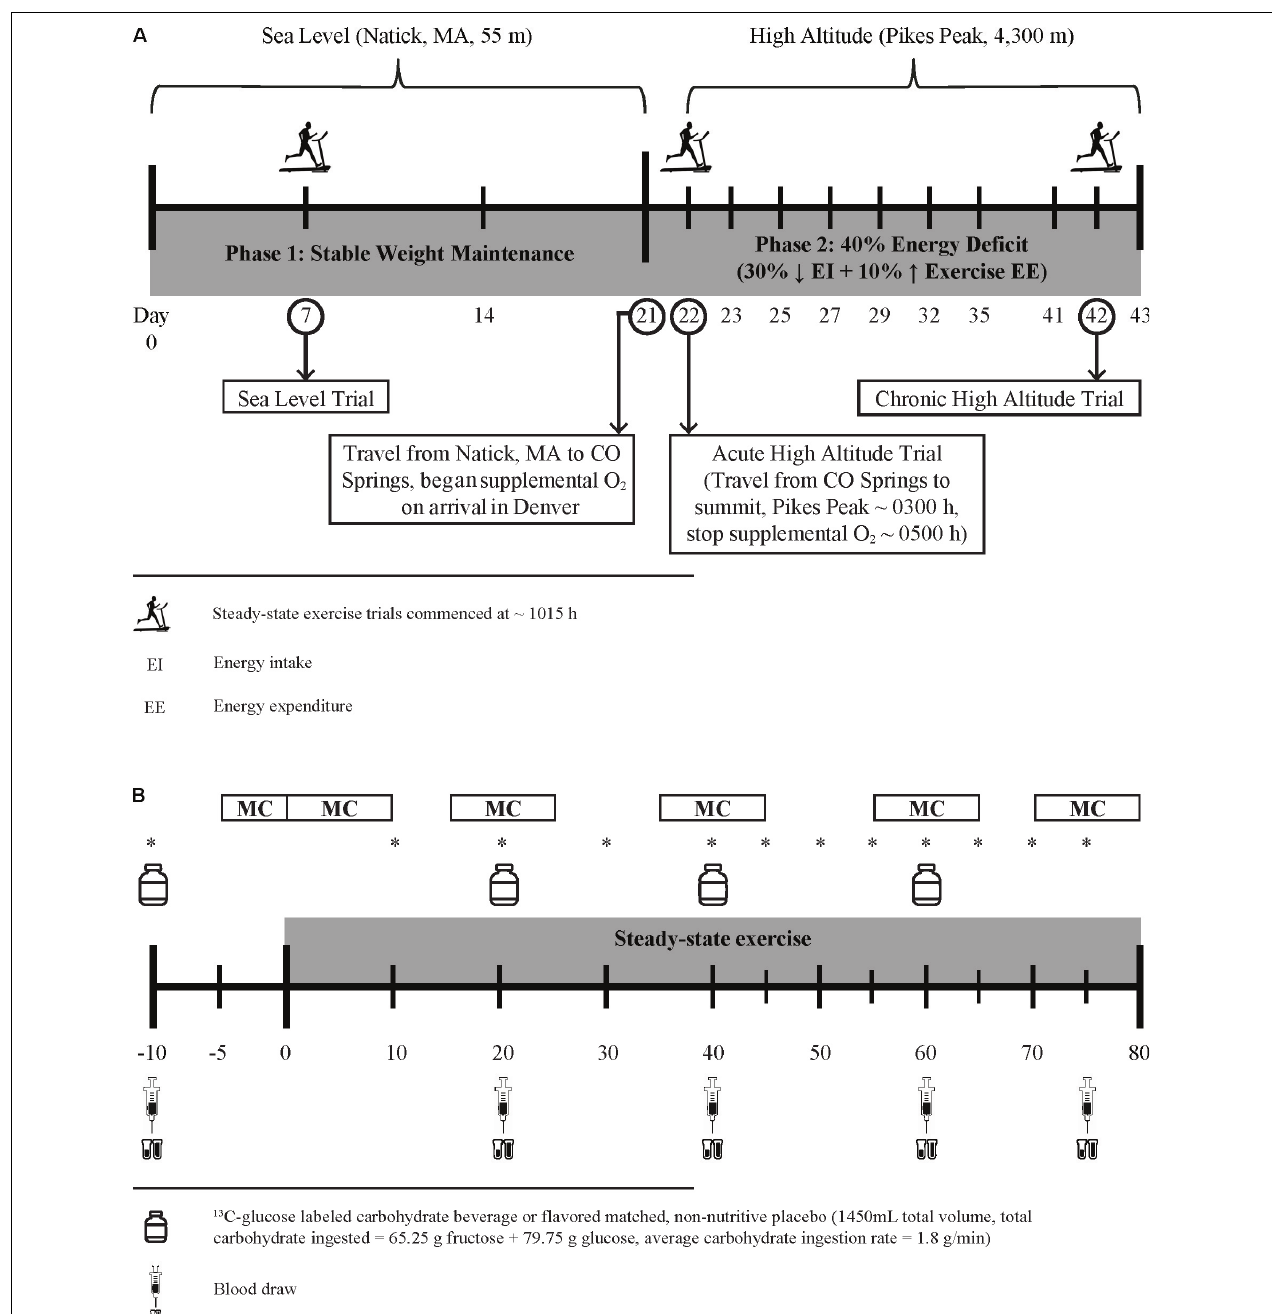
FIGURE 1 | Experimental design schematic (A) and protocol for assessment of substrate oxidation and blood metabolite changes during steady-state exercise (B)